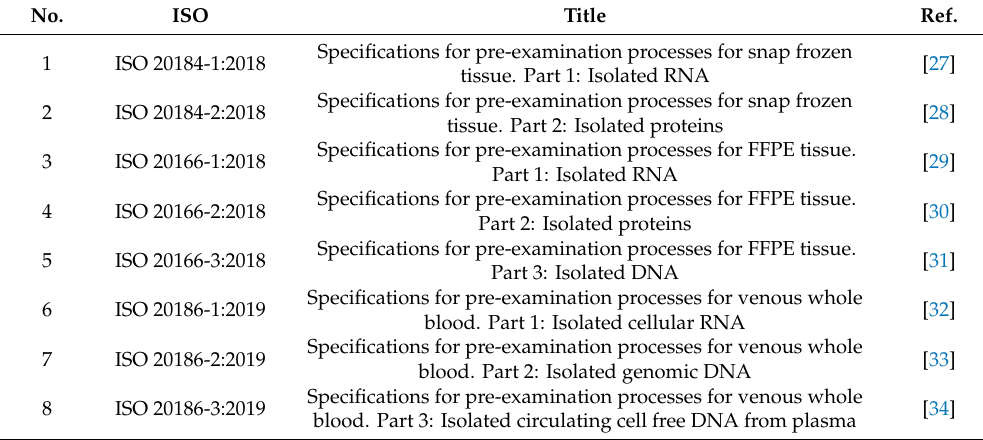
Table 1. CEN technical specifications recommended for in vitro molecular diagnostic studies. No. ISO Title